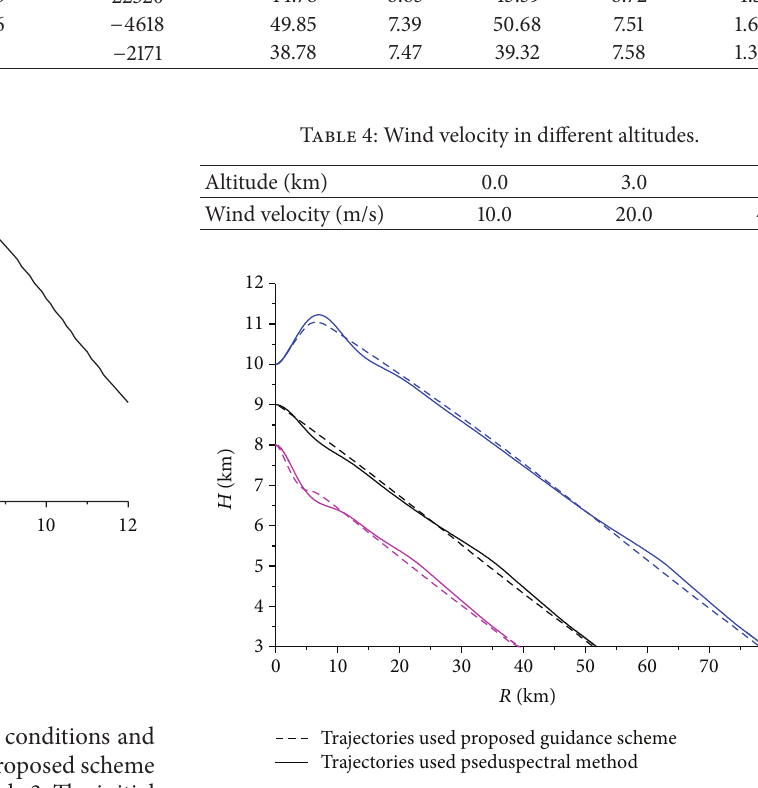
Figure 5: Gliding trajectories for Scenarios 1, 3, and